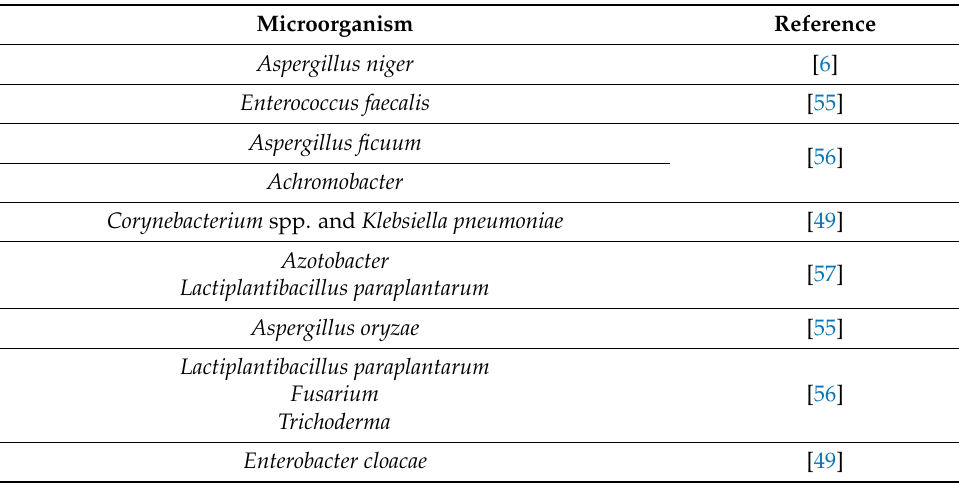
Table 2. Microorganisms used to produce